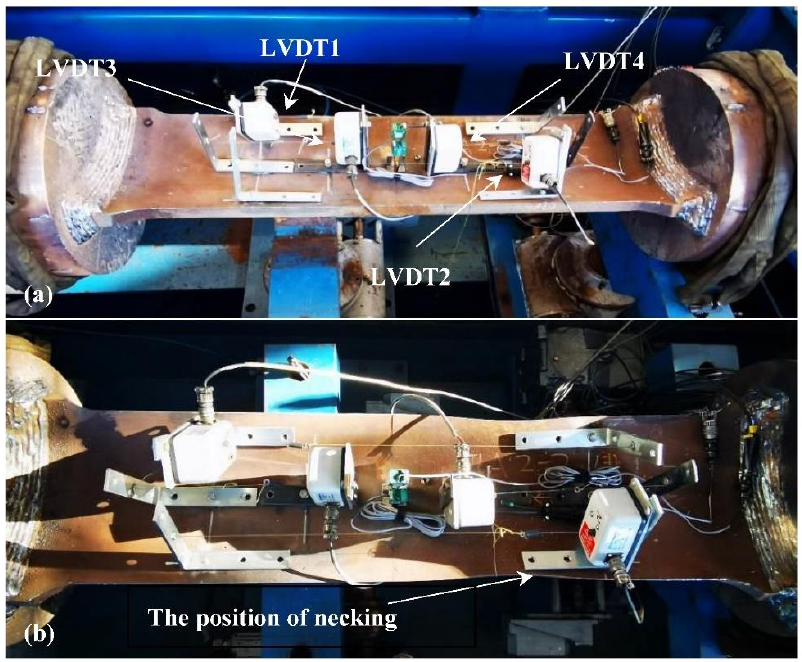
Figure 13. The test of curved wide plate (CWP) when the initial crack depth is 4 mm. ( a ) Extensom- eters installation on the specimen; ( b ) The position of necking after test.